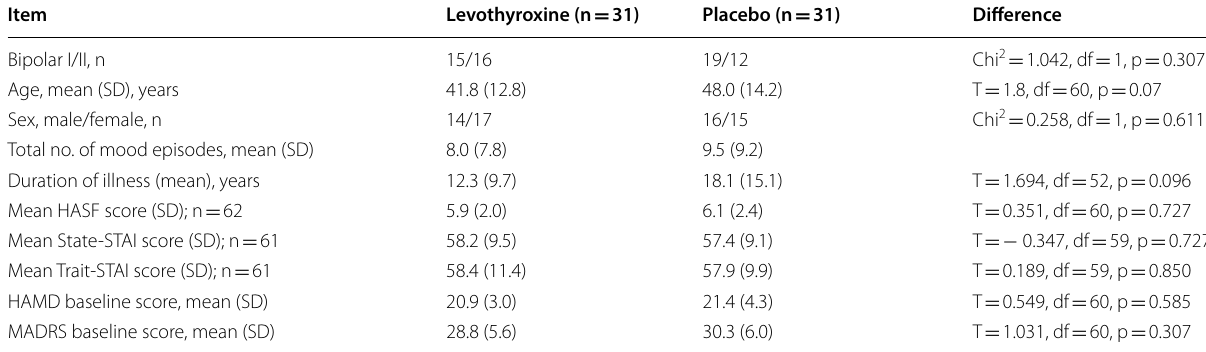
Table 1 Demographic and baseline clinical characteristics of participants with bipolar depression (intent-to-treat